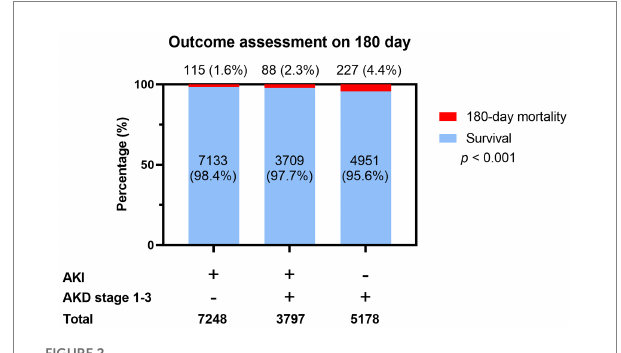
FIGURE 2 Assessment outcome among patients with different combinations of AKI and